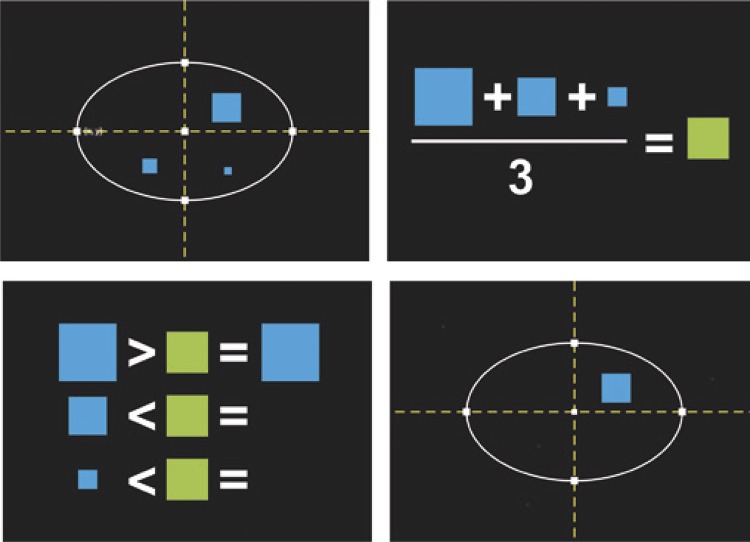
Método da eliminação de subregiões por meio do método de detecção por área. Na primeira coluna, é feita a detecção das subregiões internas ao cérebro. Na segunda, calcula-se a média aritmética das áreas das subregiões detectadas. Na terceira, realizam-se a comparação entre o tamanho de cada subregião e a média aritmética. Na última, eliminam-se todas as subregiões com área inferior ao da média